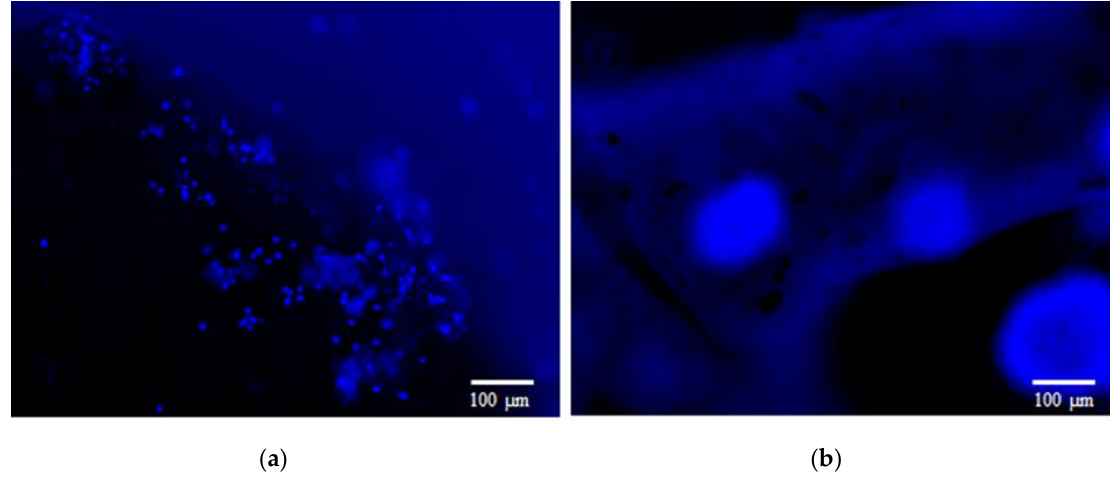
Figure 3. Cells attached to NFC1 scaffold ( a ), while they seem to not attach to the negatively charged NFC8 scaffold ( b ). Cells nuclei were stained blue, using NucBlue. Scale bar: 100 µm.